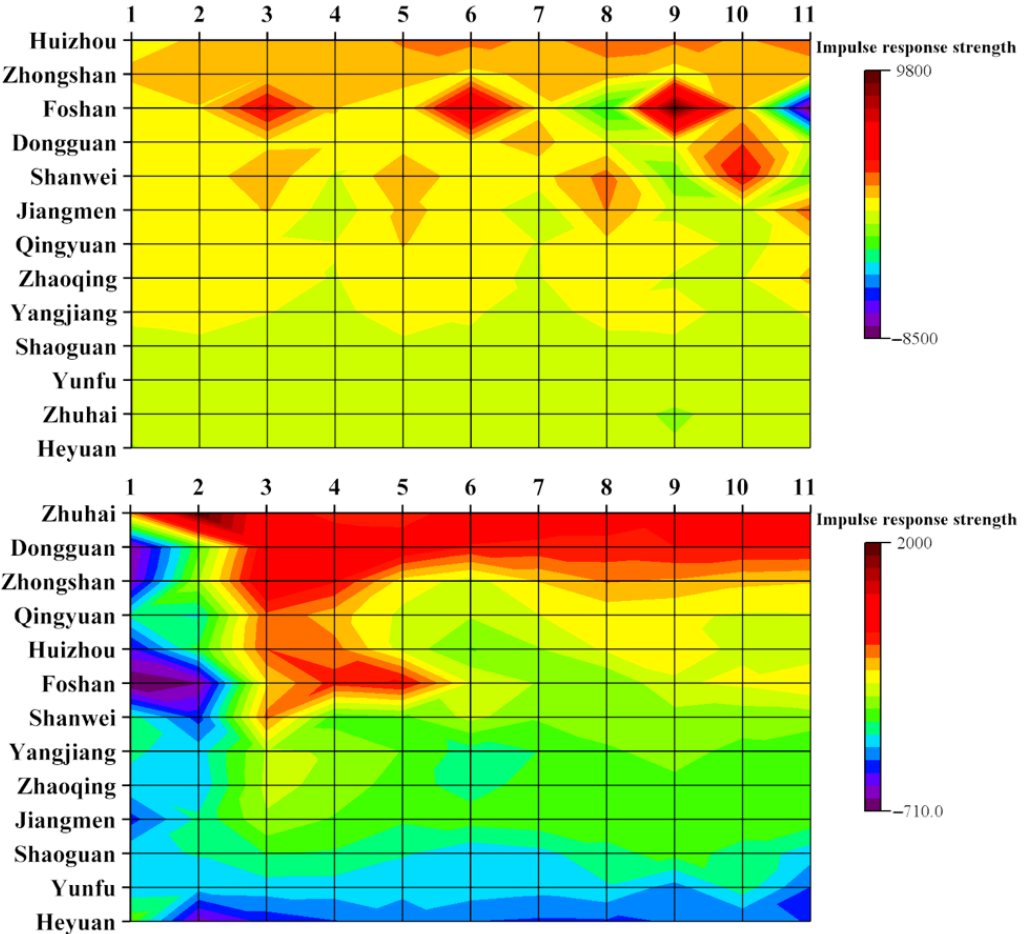
Figure 11. Impulse response results of responding cities caused by a unit impact on Guangzhou ( top ) and Shenzhen ( bottom ) housing prices in the PRDUA.